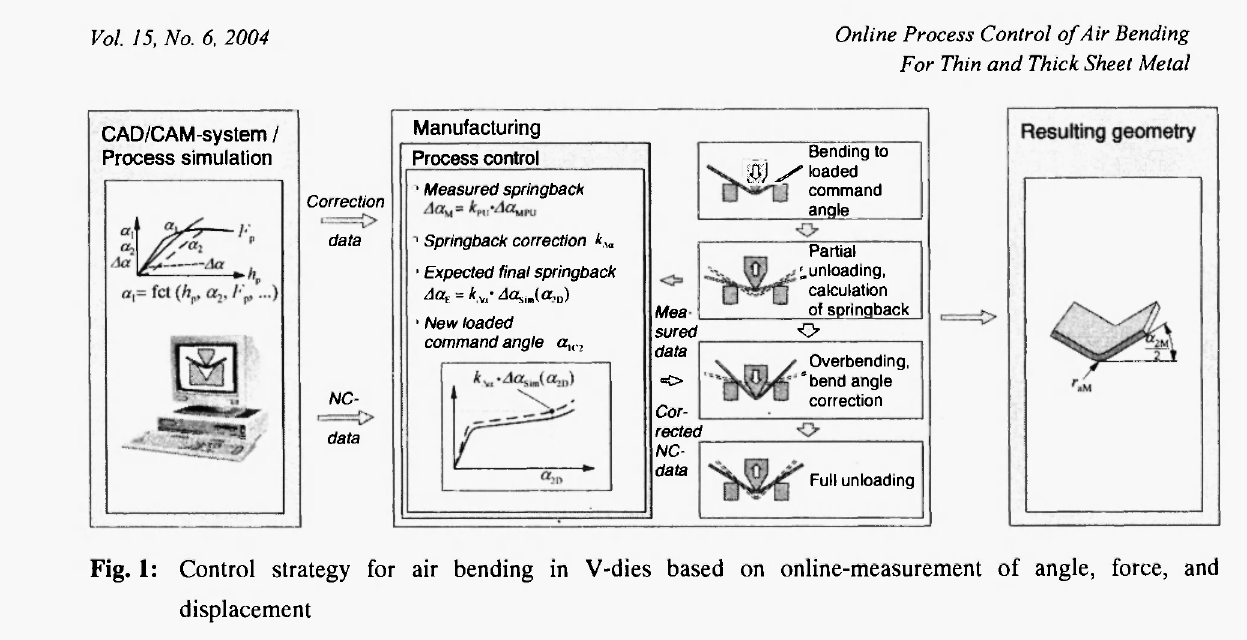
Fig. 1: Control strategy for air bending in V-dies based on online-measurement of angle, force, and